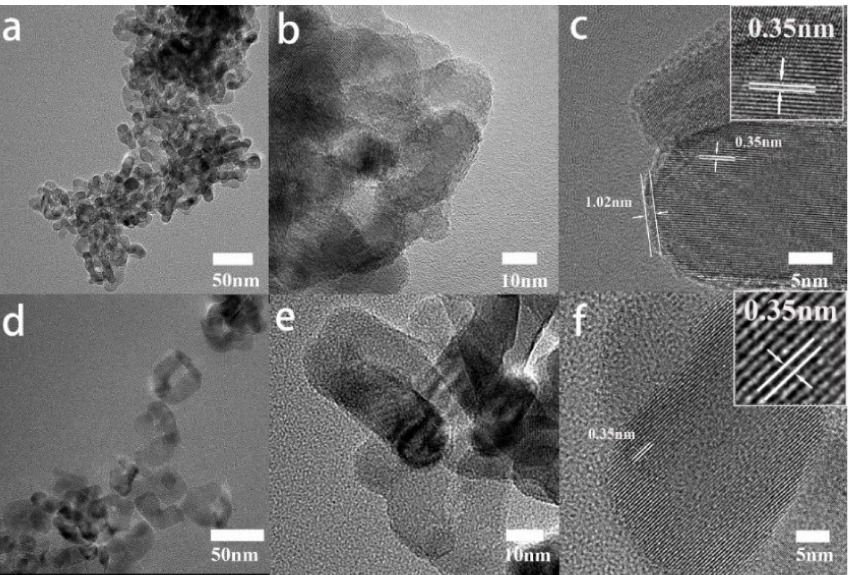
Figure 6. ( a – c ) are TEM and HRETM images of black P25 TiO 2 ; ( d – f ) are TEM and HRETM images of P25 TiO 2 without laser treatment. Insets in ( c , f ): Zoomed-in views for the TEM images. Then, we investigated the PCEs of QDSSCs fabricated with a single TiO 2 photoanode, and the corresponding device parameters are shown in Table 1. For J–V curves of anatase TiO 2 in Figure 7a, the PCE of anatase TiO 2 is 3.6% with a J sc = 18.3 mA/cm 2 , and for black anatase TiO 2 the PCE is 4.7% with a J sc = 22.9 mA/cm 2 . The overall PCE is increased